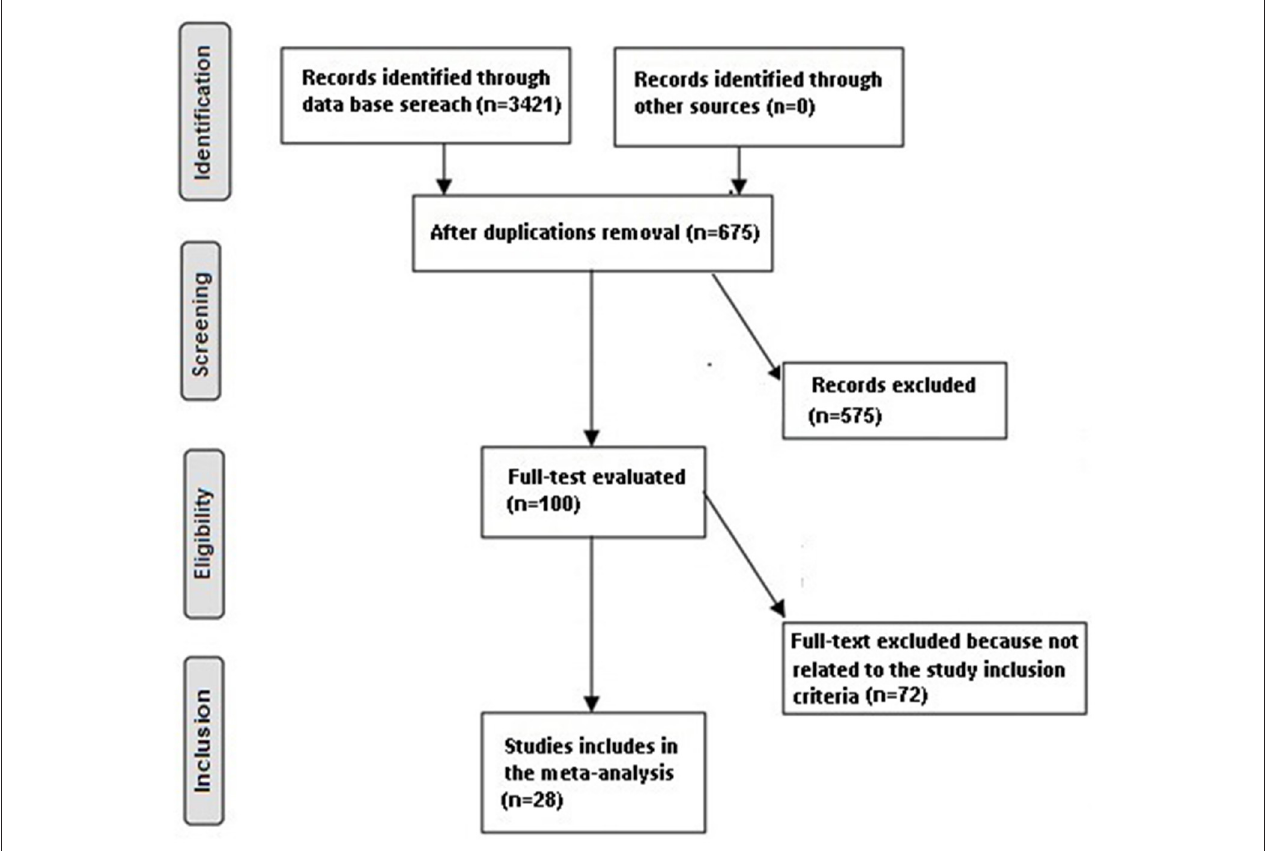
FIGURE 1 | Schematic diagram of the study